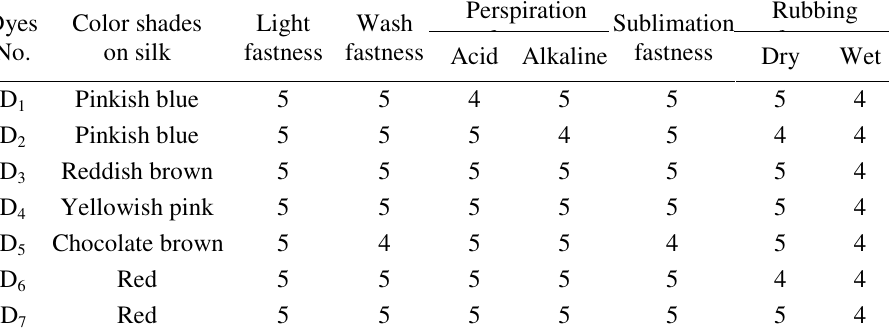
Table 5. Results of mordent acid azo dyeing and various fastness properties of dyes on silk. Perspiration